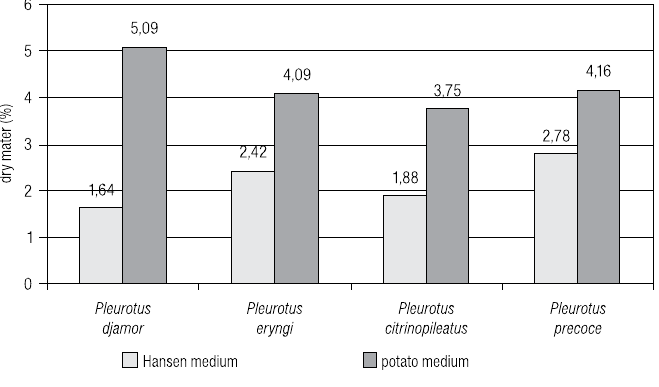
Fig. 2. Dry mycelium mass in the liquid stationary cultures depending on the medium and oyster